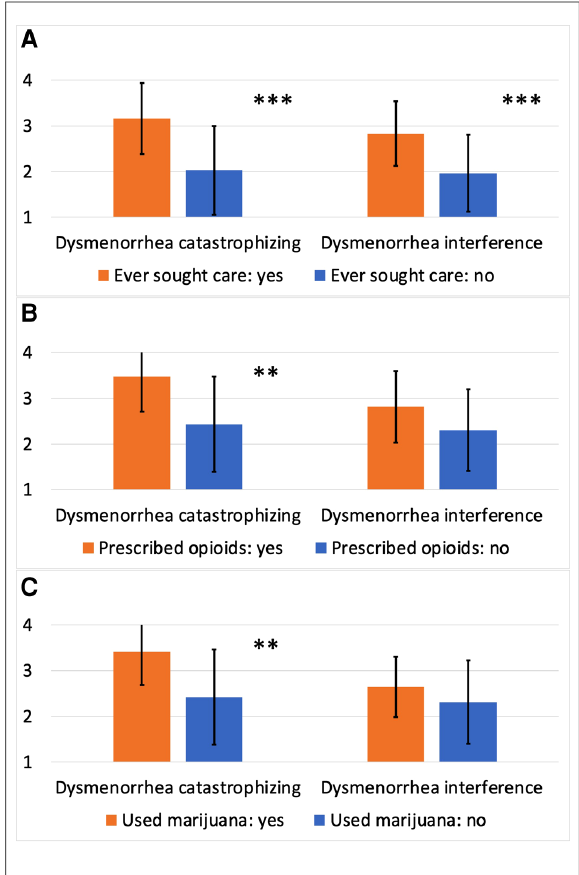
FIGURE 2 Dysmenorrhea catastrophizing and dysmenorrhea interference scores by treatment history. ( A ) Dysmenorrhea catastrophizing and dysmenorrhea interference scores by ever seeking care speci fi cally for dysmenorrhea; ( B ) dysmenorrhea catastrophizing and dysmenorrhea interference scores by ever being prescribed opioid medications for managing dysmenorrhea; ( C ) dysmenorrhea catastrophizing and dysmenorrhea interference scores by ever using marijuana for managing dysmenorrhea. *** P <0.001; ** P <